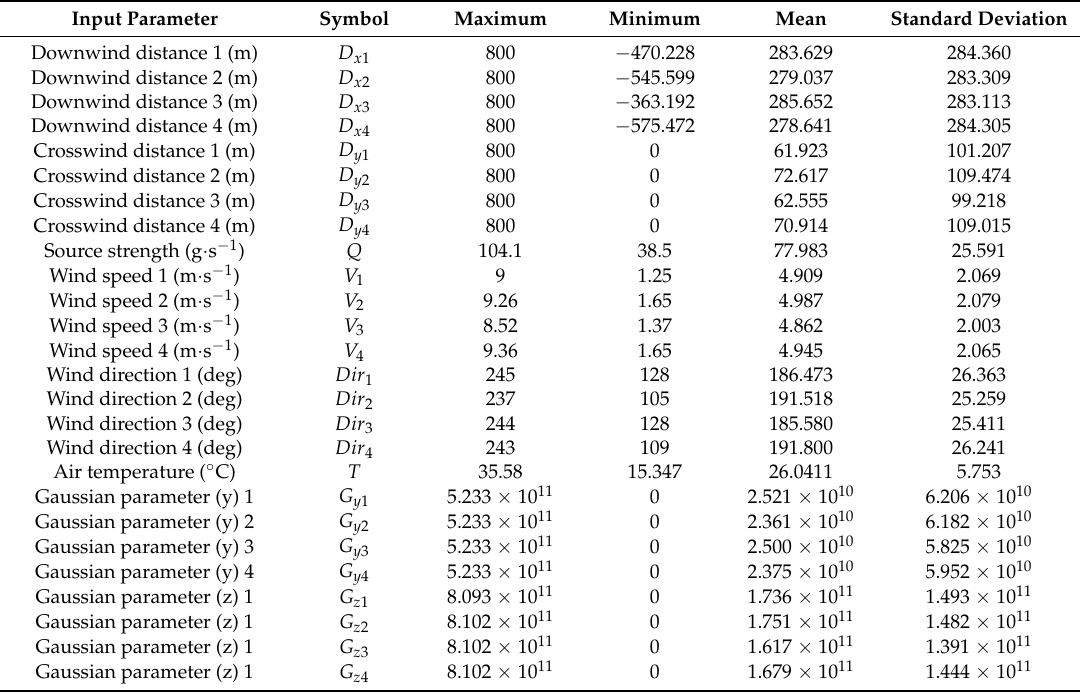
Table A1. The statistical indicators of the inputs in the Prairie Grass case.